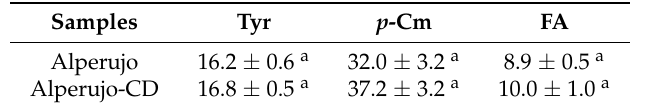
Table 2. Bioavailability of the phenolic compounds in Caco-2 cells as percentage of their initial amount in the test meal before in vitro